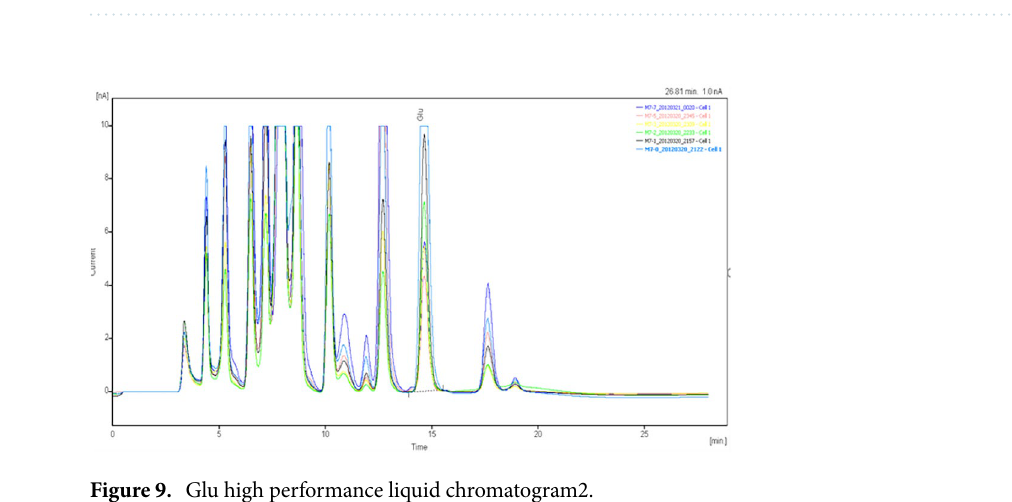
Figure 8. Glu high performance liquid chromatogram1.